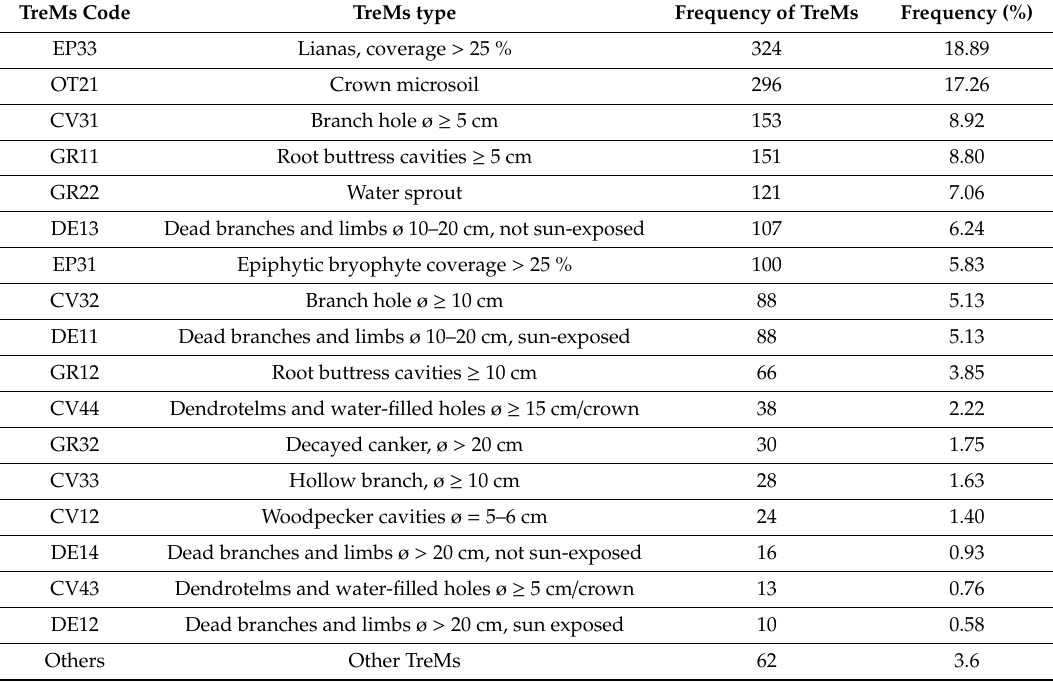
Table 2. TreMs frequency. The list refers to the TreMs frequencies within all 35 plots. The record “Other” refers to 23 TreMs types that present individual frequencies lower than